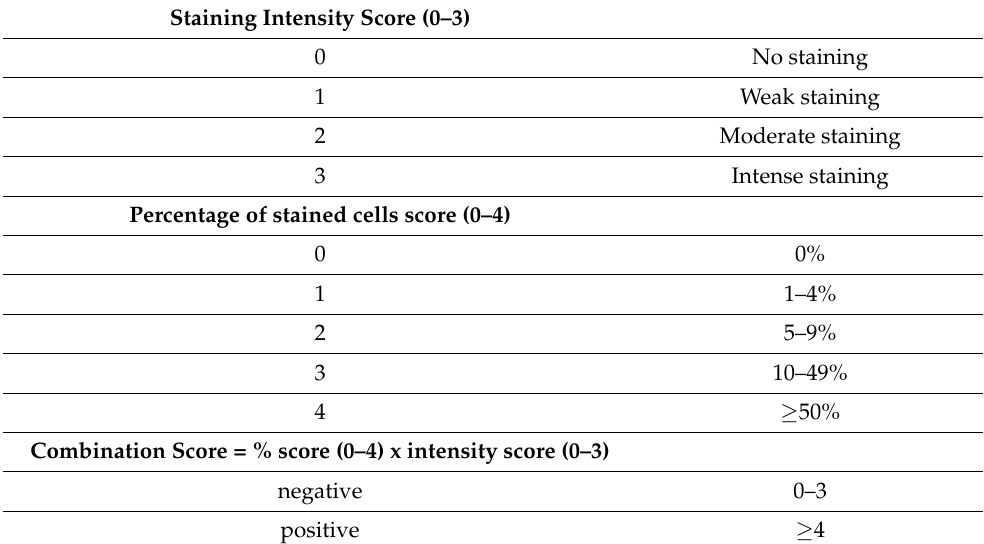
Table 1. Semi-quantitative IHC